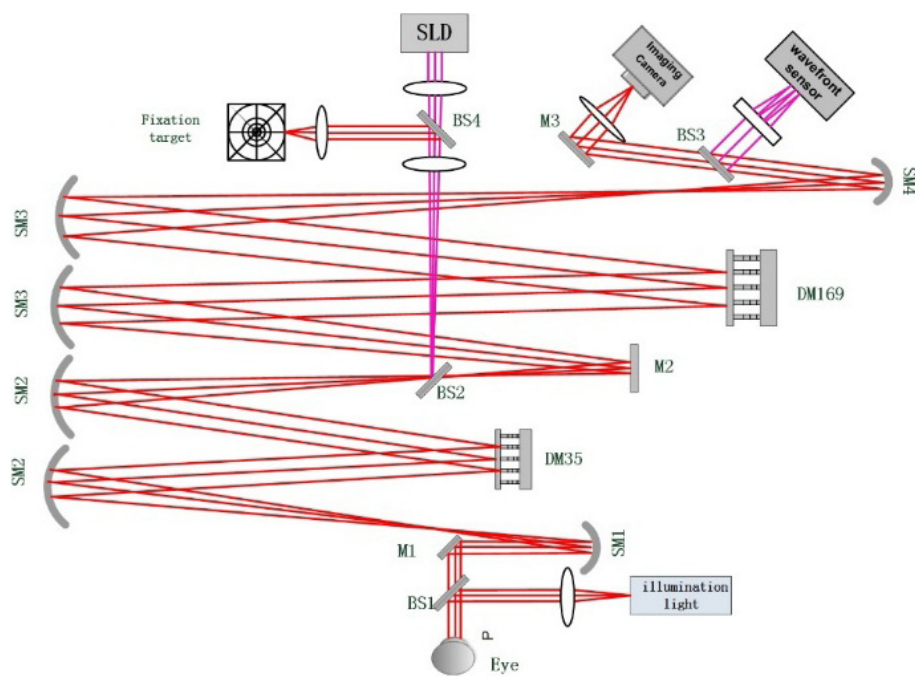
Fig. 6. Schematic diagram of dual DM °ood-illumination system for retinal imaging. SLD super-luminescent diode; SM spherical mirror: SM1 ( f ¼ 180 mm), SM2 ( f ¼ 600 mm), SM3 ( f ¼ 1050 mm), SM4 ( f ¼ 195 mm); BS beam splitter; M mirror; DM deformable